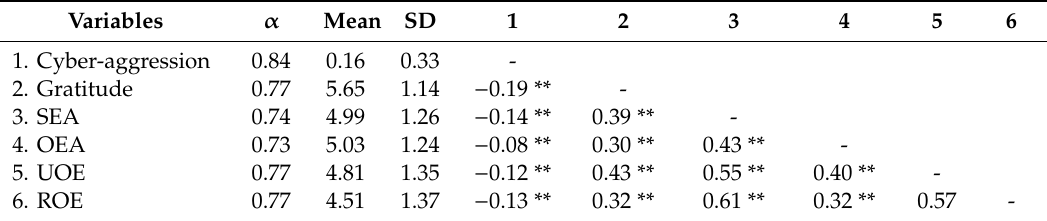
Table 1. Descriptive statistics, internal consistency and correlations among